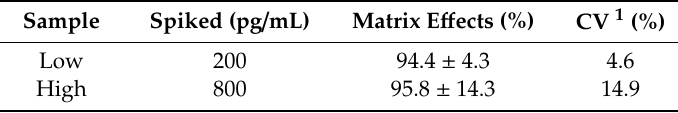
Table 2. Matrix e ff ects of OT spiked in dog